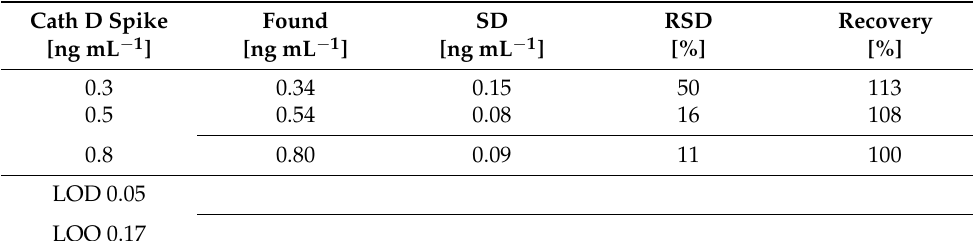
Table 6. Precision and recovery of Cath D determination using the biosensor with an Ag/Au chip and adhesive foil as a separating